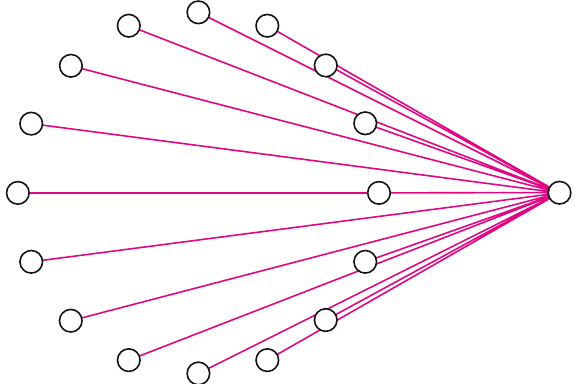
Figure 5. Graph to implement the n -target CNOT gate.